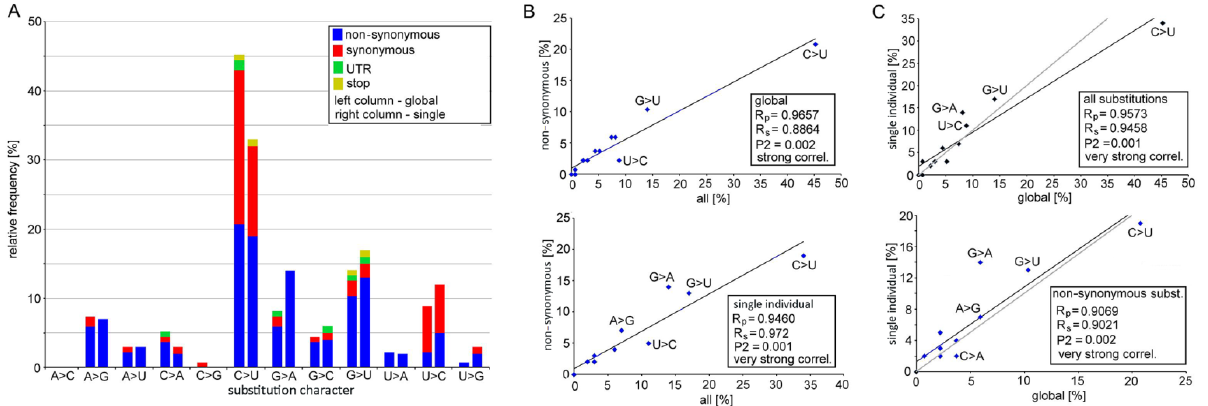
Figure 2. Mutation spectra of SARS-CoV-2 genomes analyzed in global data sets and virus sequences isolated from a single patient. ( A ) Relative frequency of individual types of substitutions. Left columns: the character of 135 substitutions identified in eight global lineages (Figure 1); Right columns: the character of 100 substitutions identified in virus genomes from a single individual. Data can be found in Tables S3 and S4. ( B,C ) The Spearman’s and Pearson’s statistics for 12 types of substitutions: (B) Correlation between the non-synonymous and all substitutions for global sets (upper panel) and single individual (bottom) levels. (C) Correlation between global sets and virus genomes from a single individual for all (upper panel) and non-synonymous (bottom) substitutions. Black lines represent linear regressions derived from measurements. Gray lines represent the equality between global data sets and a single individual (y = x).